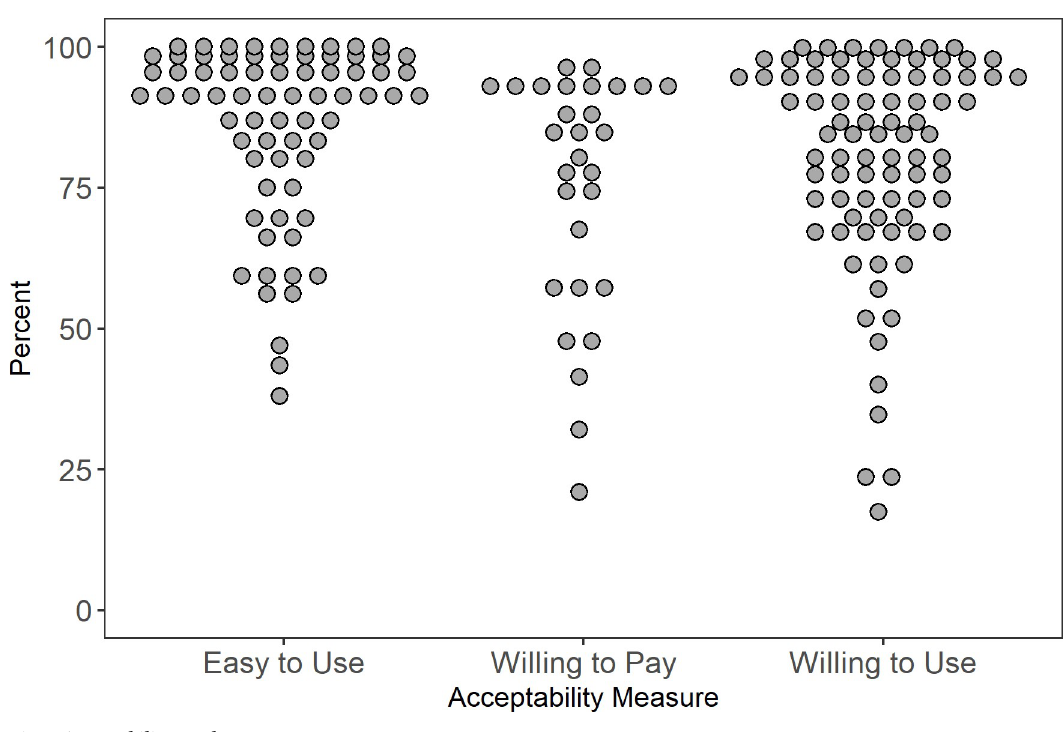
Fig 3. Acceptability